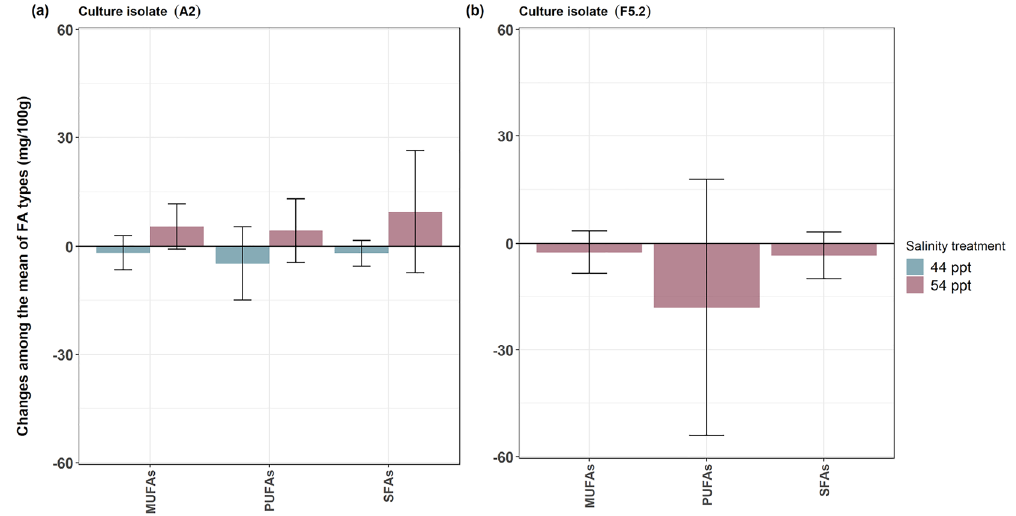
Figure 4. Changes in fatty acid (FA) concentration (mg 100 g −1 of FAME production) at different salinity treatments grouped by FA class for all individual FA profiles (MUFA = Monounsaturated fatty acids, SFA = Saturated fatty acids, PUFA = Polyunsaturated fatty acids); ( a ) Symbiodinium pilosum [A2] culture isolate after treatment with f/2 media at 44 ppt and 54 ppt salinities in comparison to f/2 media at 34 ppt (normal salinity; zero line). ( b ) Fugacium sp. [F5.2] culture isolate after treatment with f/2 media at 54 ppt salinity only in comparison to f/2 media at 34 ppt (normal salinity, zero